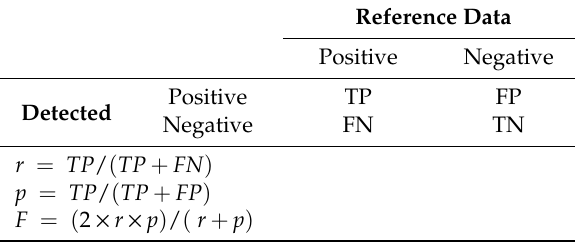
Table 1. Tree detection error matrix (TP = true positive, FN = false negative, FP = false positive, TN = true